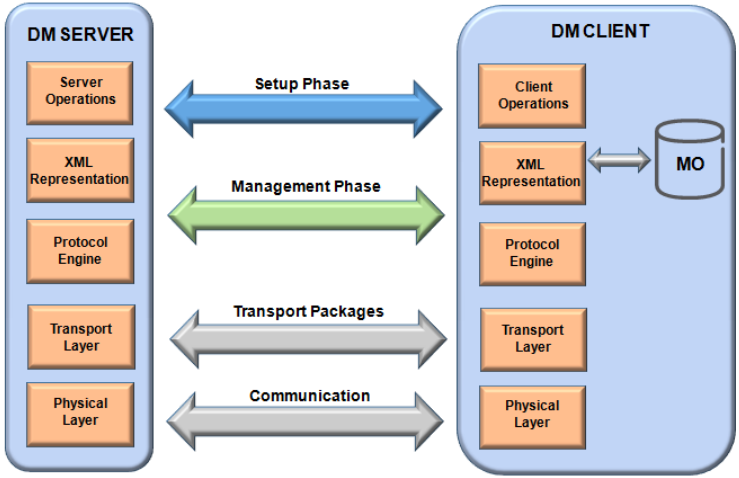
Figure 17. OMA-DM standard management